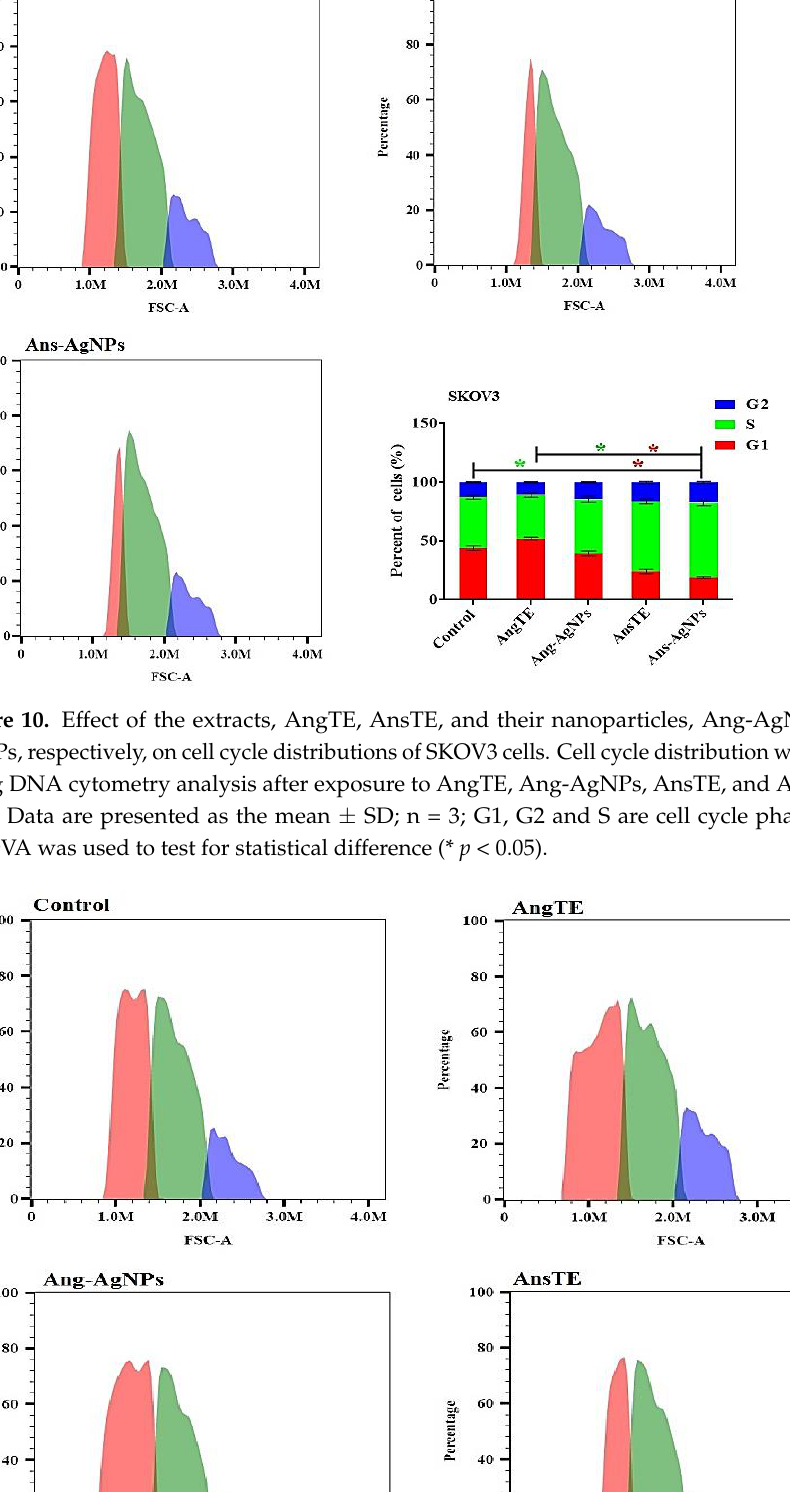
Figure 11. Effect of the extracts, AngTE, AnsTE, and their nanoparticles, Ang-AgNPs, and Ans- AgNPs, respectively, on cell cycle distributions of HeLa cells. Cell cycle distribution was determined using DNA cytometry analysis after exposure to AngTE, Ang-AgNPs, AnsTE, and Ans-AgNPs for 48 h. Data are presented as the mean ± SD; n = 3; G1, G2 and S are cell cycle phases, One-way ANOVA was used to test for statistical difference (* p < 0.05). Cell Apoptosis Using Annexin V-FITC In PC3, SKOV3, and HeLa cells, annexin V-FITC/PI staining by a flow cytometer was used to distinguish between cells undergoing apoptosis (programmed cell death) and cells dying via necrosis (non-programmed cell death). There was an increase in the popu- lation of apoptotic cells in PC3 cells after treatment with AnsTE of 79.63 ± 3.3%, (Figure 12), as well as in SKOV3 after treatment with AnsTE of 83.1 ± 2.2% and Ans-AgNPs with apoptotic populations of 83.03 ± 2.04, compared to the cell control (Figure 13). Prolonged exposure of HeLa cells to AnsTE and Ans-AgNPs for 48 h significantly induced the num- ber of apoptotic cells by 80.93 ± 3.4% and 83.49 ± 3.7%, respectively (Figure 14), compared to the control cells. In conclusion, AnsTE used at pre-calculated IC 50 induced a significant apoptotic effect against all tumor cells (PC3, SKOV3, and HeLa).